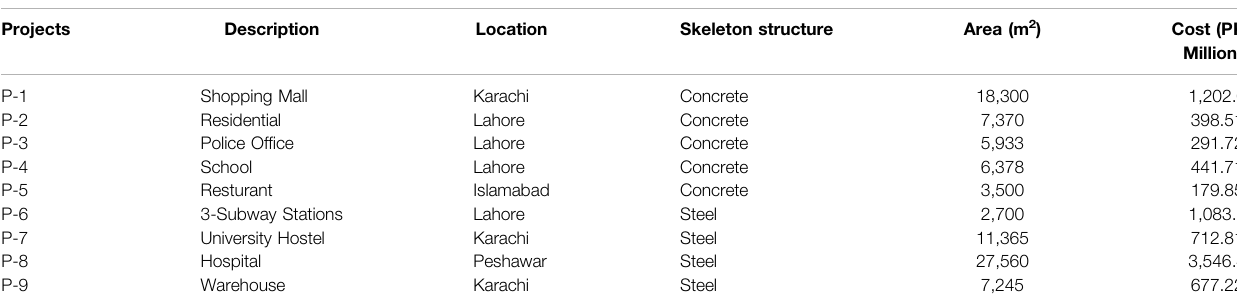
TABLE 2 | Description of construction projects.